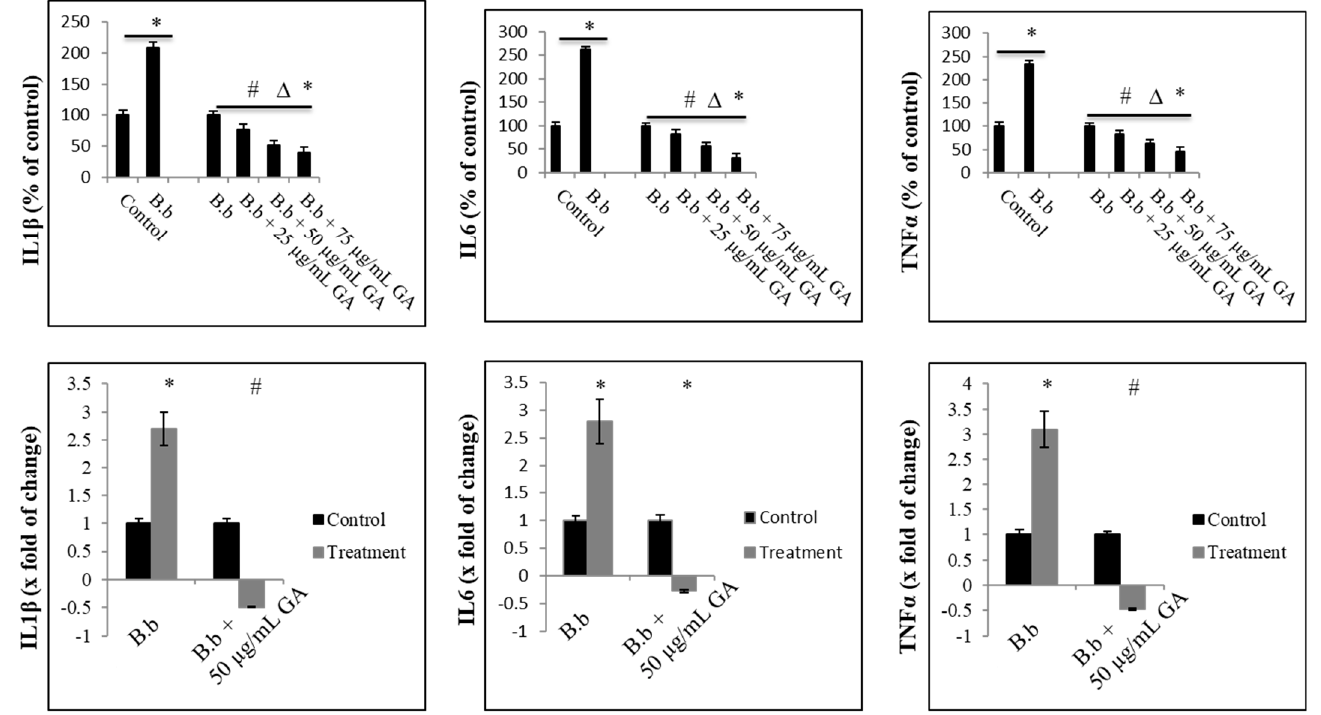
Figure 3. Proinflammatory cytokine secretion and expression status. Human CD14+ monocytes were treated with gallic acid (GA) upon B. burgdorferi 31 stimulation. Levels of secreted proinflammatory cytokines were assessed using ELISA after 12 h post-treatment ( upper panel ) and with RT-qPCR after 24 h post-treatment ( lower panel ). Control—cells not stimulated with B. burgdorferi ; B.b —control cells stimulated with B. burgdorferi at cells:bacteria 1:5 ratio; # p ≤ 0.05, ∆ p ≤ 0.01, * p ≤ 0.001; control—DMSO only (0.035%).